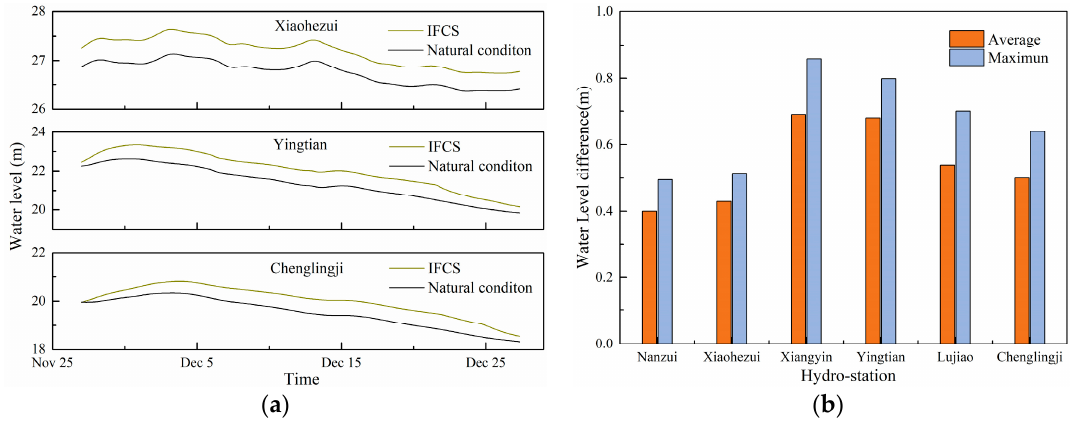
Figure 9. The variation of the water level with IFCS (27 November to 27 December 2016): ( a ) the fluctuation of the water level at the selected station; ( b ) the average and maximum water level differences in the Dongting Lake.